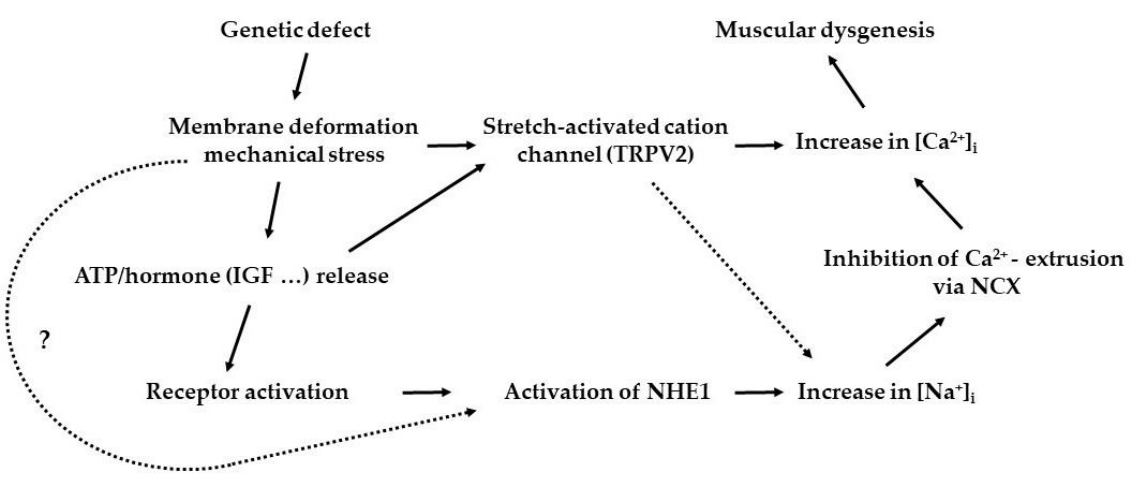
Figure 2. A possible pathway leading to muscle dysgenesis in BIO14.6 dystrophic hamsters. Abbre- viations: ATP, adenosine triphosphate; IGF, insulin-like growth factor; TRPV2, transient receptor potential cation channel, subfamily V, member 2 protein; NHE1, Na + /H + exchanger, isoform 1; NCX, Na + /Ca 2+ exchanger.